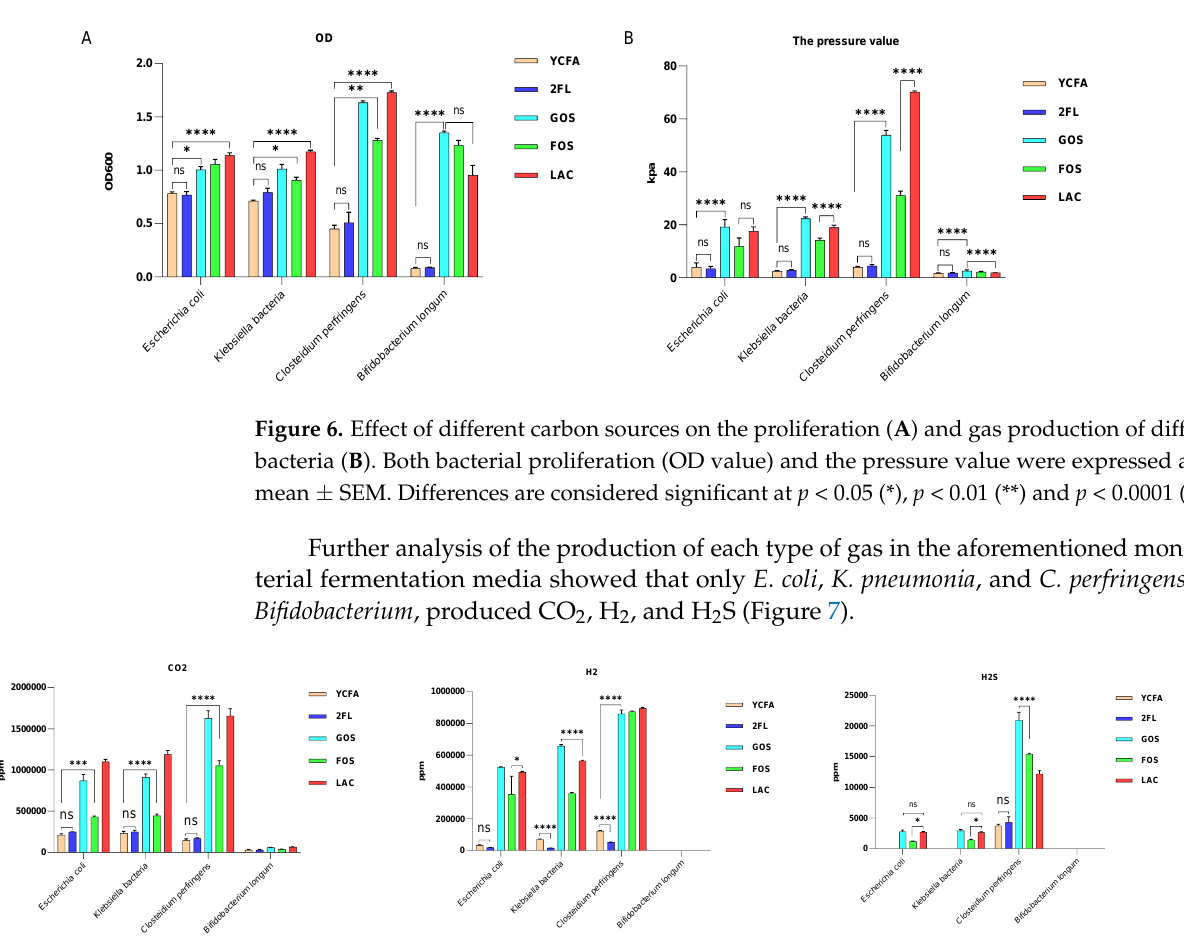
Figure 7. Analysis of the types of in vitro fermentation gases produced by different bacterial strains. The production of CO 2 , H 2 , and H 2 S were expressed as the mean ± SEM. Differences are considered significant at p < 0.05 (*), p < 0.001 (***), and p < 0.0001 (****).